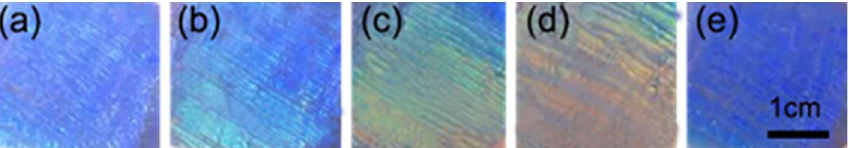
Figure 8. The structural color of the SF-PNIPAM dual-crosslinked nanocomposite film (5 mm) with different deformations ( a ) 0%; ( b ) 5%; ( c ) 10%; ( d ) 15%; ( e ) Remove external force.